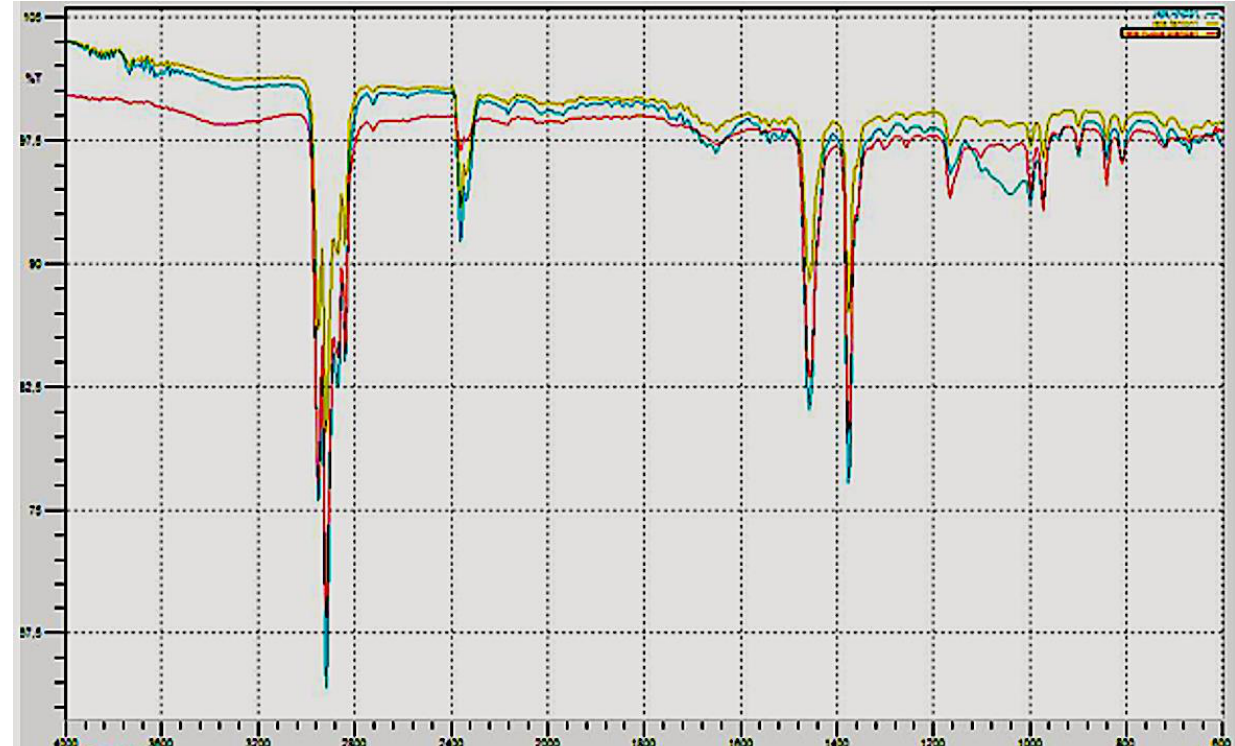
Figure 7. Comparison of IR spectrum of treated and new PP socks. Green = H 2 O 2 treatment, blue = HNO 3 treatment, red = untreated.